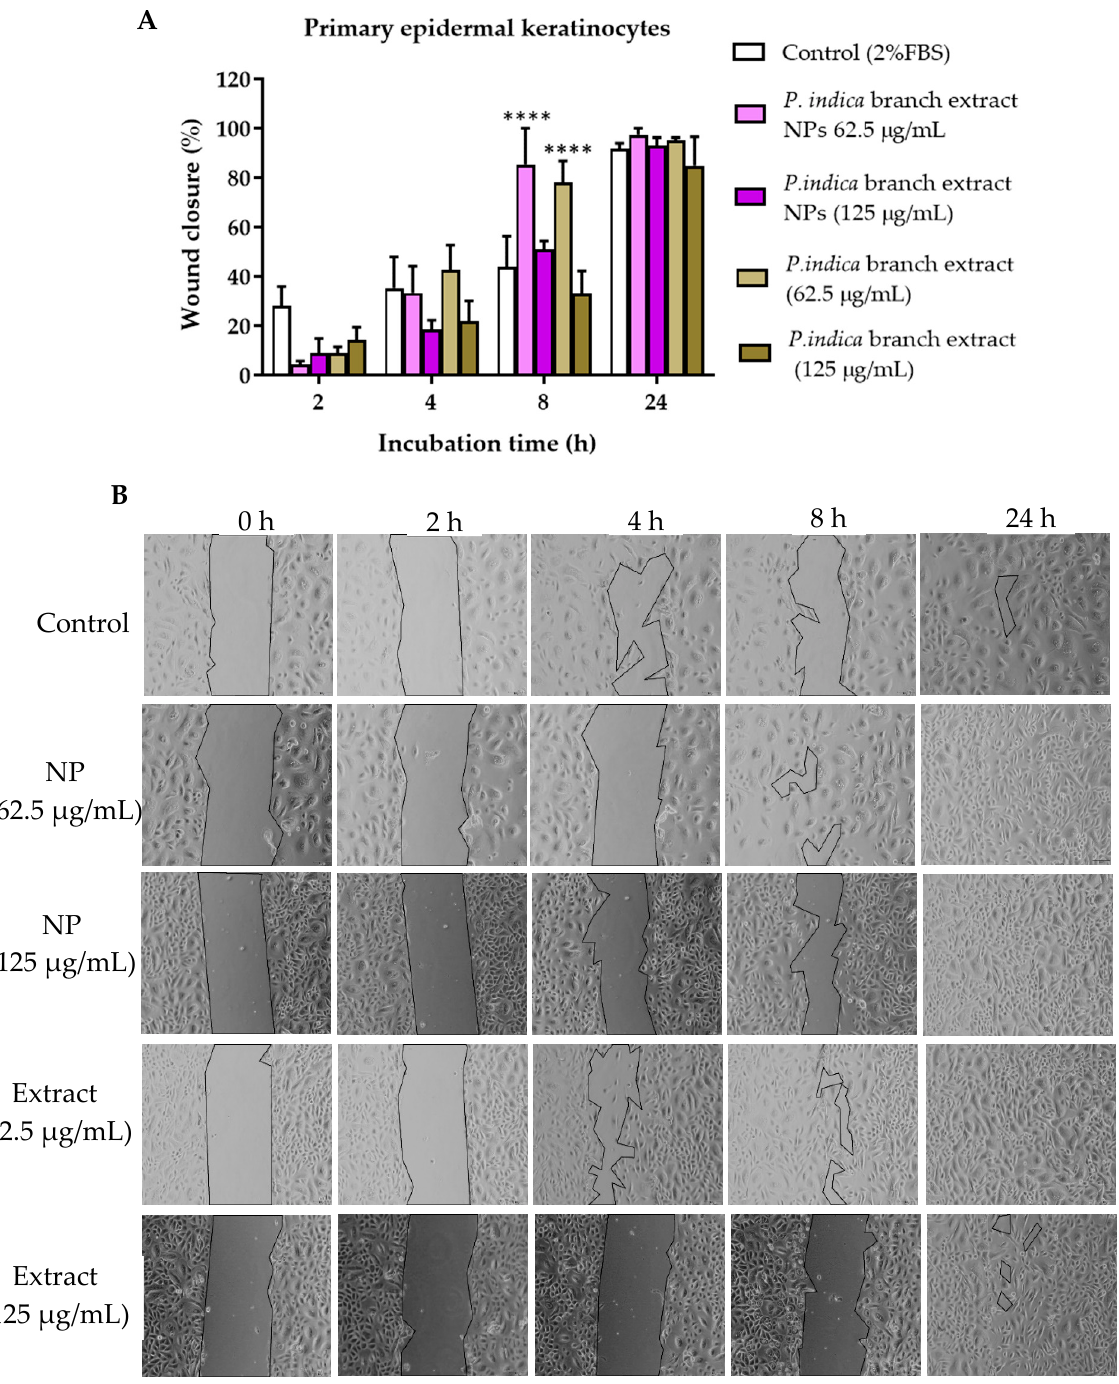
Figure 7. ( A ) Microscopic images of primary epidermal keratinocytes treated with P. indica branch extract in the scratch assay. ( B ) The images were captured at 0, 2, 4, 8, and 24 h after incubation. The data represent the mean ± SEM of three experiments. **** indicates p < 0.0001 compared with control.